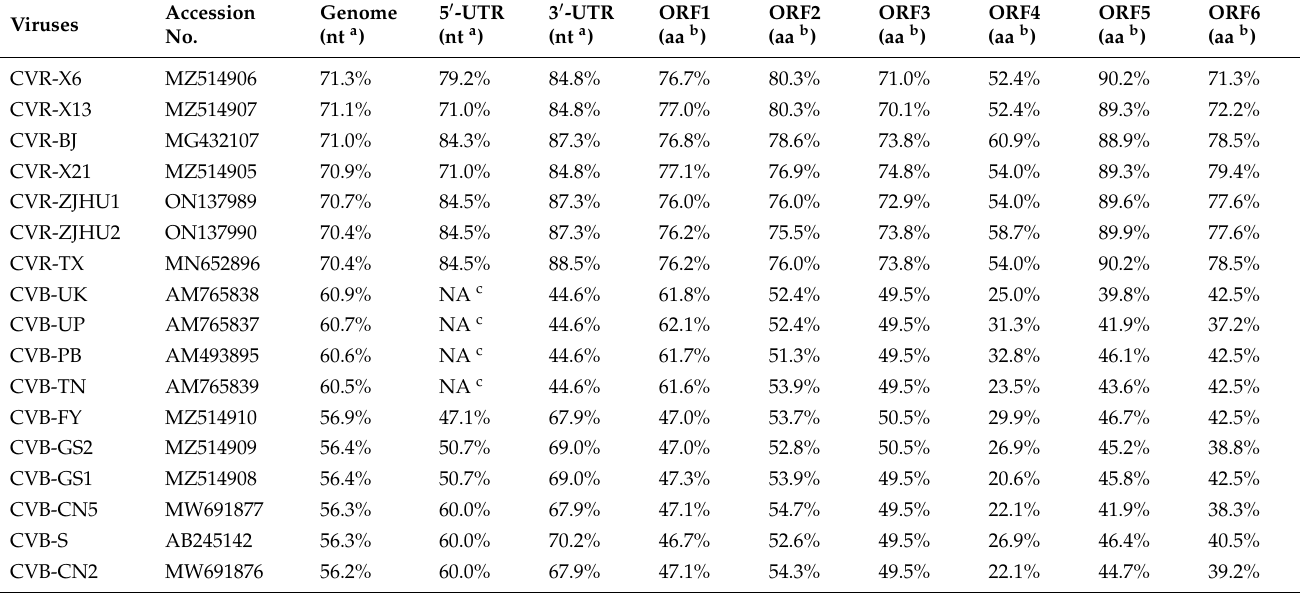
Table 1. Nucleotide and protein sequence identities (%) of the Chinese isolate of Carya illinoinensis carlavirus 1 (CiCV1-CN) and the other 17 carlaviruses from C. morifolium